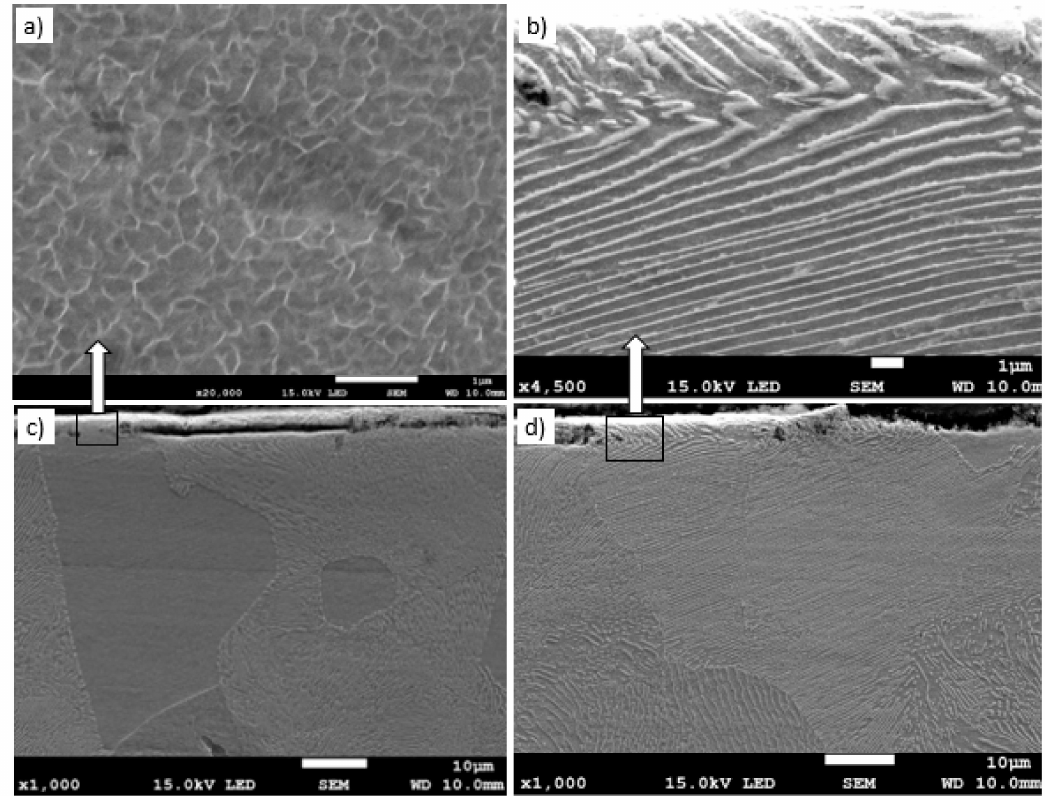
Figure 10. The microstructure of the surface layer of the C45 steel after grinding to a depth of 8 µ m with deformation of ferrite ( a ), ( c ) and pearlite ( b ), ( d ) grains in the work-hardened surface layer. Part of the work-hardened surface layer is detached from the substrate